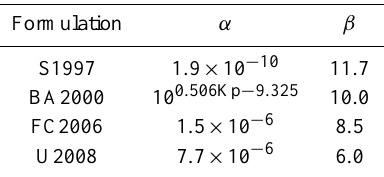
Fig. 2. Comparison of the four formulations of D LL used in this study. Because the formulation of Brautigam and Albert (2000) is Kp dependent, it is shown for several different Kp values. Table 1. A comparison of the different D LL formulations used in this study in terms of α and β